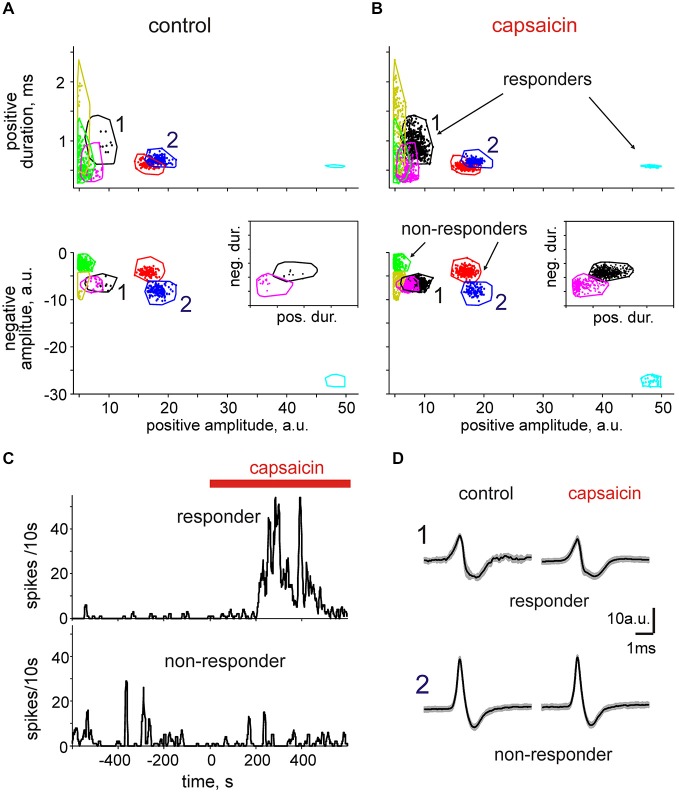
Cluster analysis of spikes in
nervus spinosus. (A) A typical presentation of spike clusters in 2D in control (spontaneous activity). Positive spike amplitudes are plotted vs. positive spike durations (top) and vs. the negative spike amplitudes (bottom). Each individual dot corresponds to a single spike. Color contours outline individual spike clusters separated on the basis of KlustaKwik methods. 1 and 2 indicate responder and non-responder clusters, respectively. (B) Spike clusters from the same predation as shown on panel (A) in the presence of 2 μM capsaicin. Notice that some units (black and magenta) increased firing during application of capsaicin (responders) whereas others (blue and green) were insensitive to capsaicin (non-responders). Inset indicates the isolated presentation of two clusters (magenta and black) when the negative duration was plotted vs. positive duration which were less distinguishable in other projections. (C) Time course of spike frequency of the units 1 (responder) and 2 (non-responder) before and after addition of capsaicin. (D) Average spike shapes for the clusters 1 and 2 (mean ± SD; responder: n = 9 in control, n = 475 in capsaicin; non-responder: n = 160 in control, n = 97 in capsaicin).